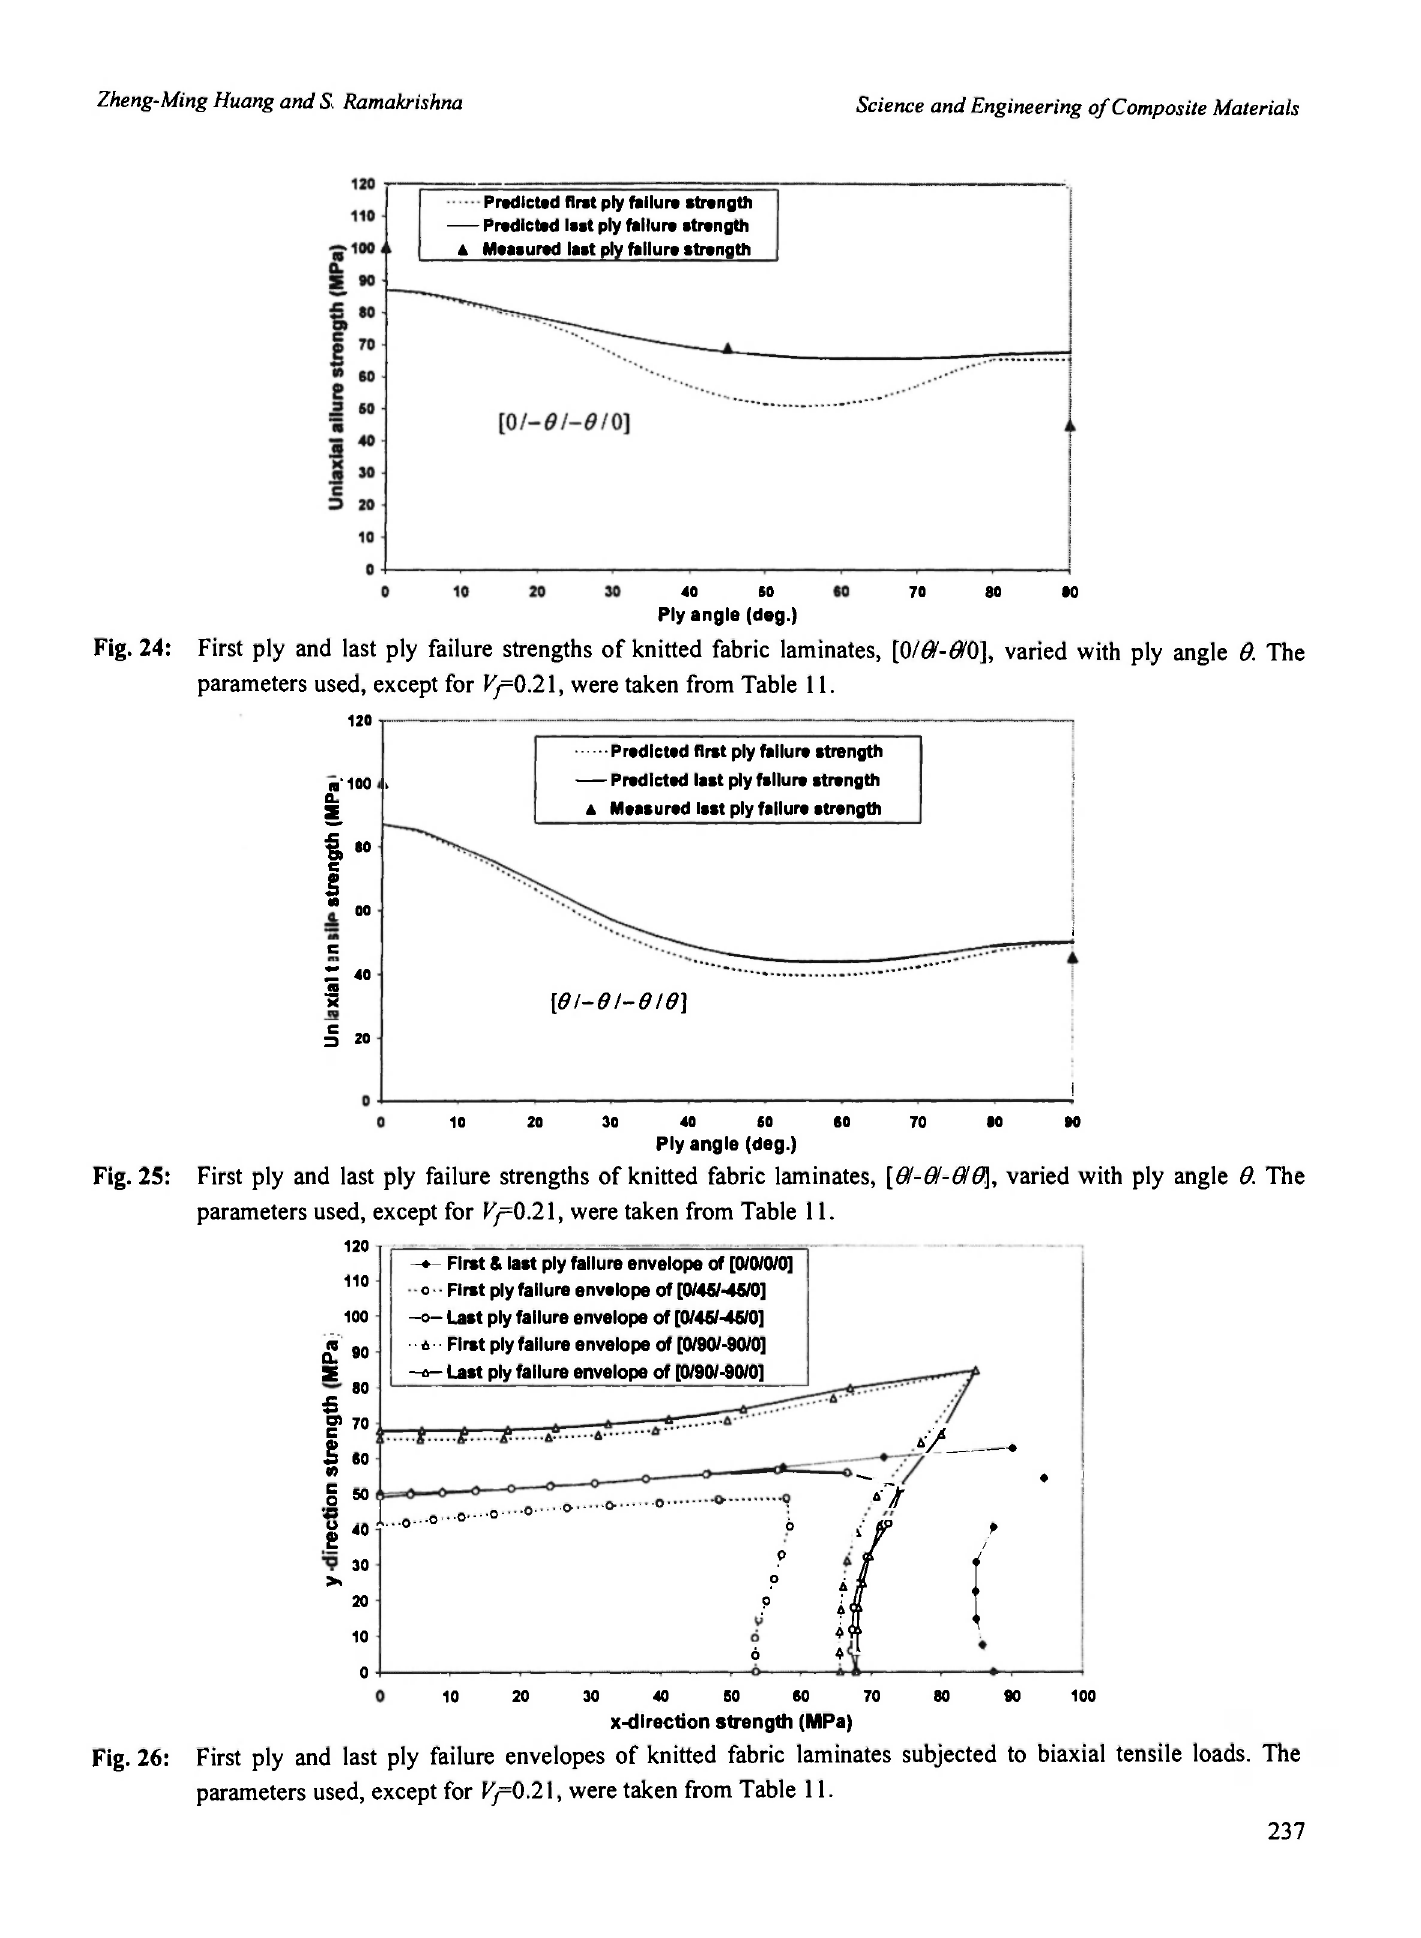
Fig. 25: First ply and last ply failure strengths of knitted fabric laminates, [ ΘΙ-ΘΙ-ΘΙΘ ], varied with ply angle Θ. The parameters used, except for Vj= 0.21, were taken from Table 11.